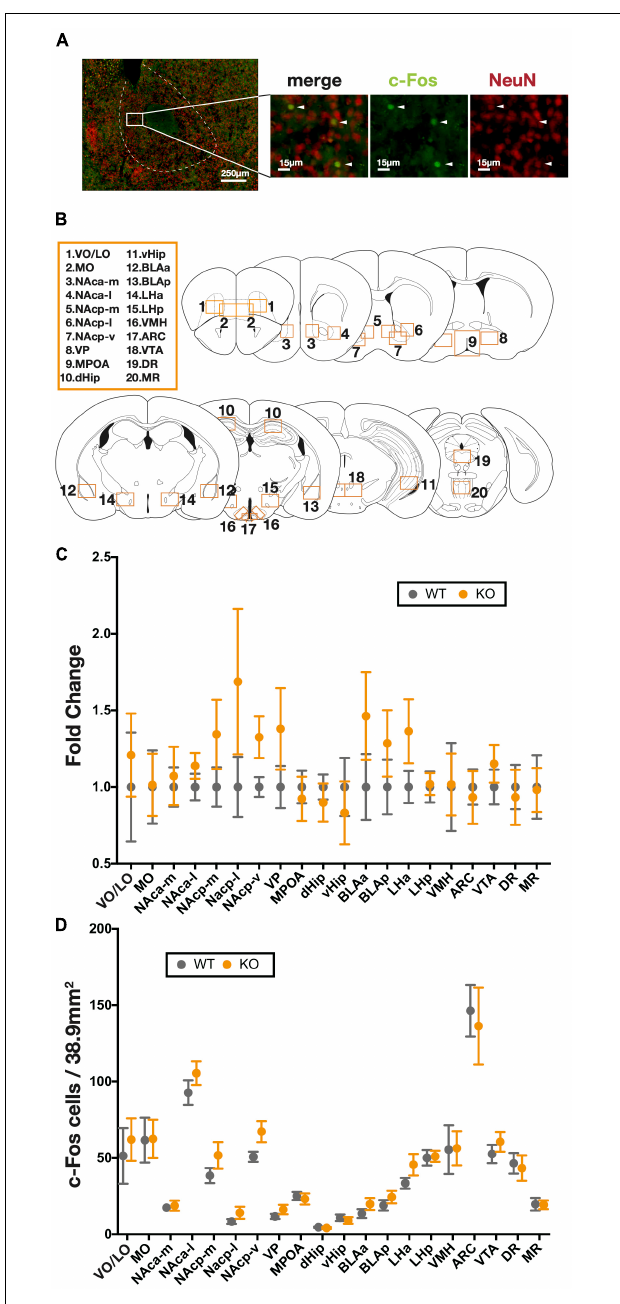
FIGURE 3 | c-Fos mapping of 20 brain regions following the progressive ratio schedule test. (A) Representative image of c-Fos positive cells, white head arrows indicate counted cells. (B) Twenty brain regions in which c-Fos-positive cells were counted. (C) Fold change from WTs in the number of c-Fos-positive cells in each region. (D) The number of c-Fos positive cells in each region. Data represent the mean ± SEM, two-way ANOVA and genotype effect at each region, a post hoc Bonferroni multiple comparison test (WT = 10, KO = 9). ARC, arcuate nucleus; BLA, basolateral amygdala; dHip, dorsal hippocampus; DR, dorsal raphe nucleus; LH, lateral hypothalamus; MO, medial orbital area; MPOA, medial preoptic area; MR, median raphe nucleus; NAc, nucleus accumbens (a, anterior; p , posterior; m, medial; l, lateral; v, ventral), vHip, ventral hippocampus; VMH, ventromedial hypothalamic nucleus; VO/LO, ventral and lateral orbital area; VP, ventral pallidum; VTA, ventral tegmental